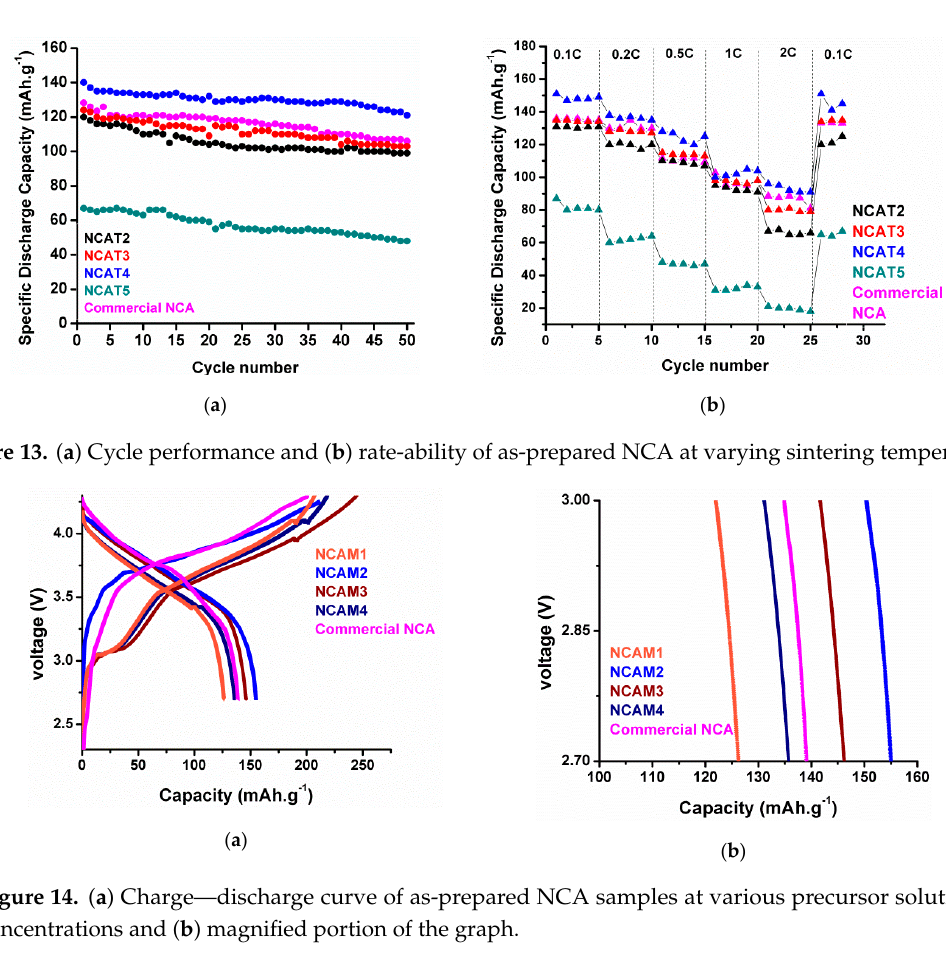
Figure 14. ( a ) Charge—discharge curve of as-prepared NCA samples at various precursor solution concentrations and ( b ) magnified portion of the graph.